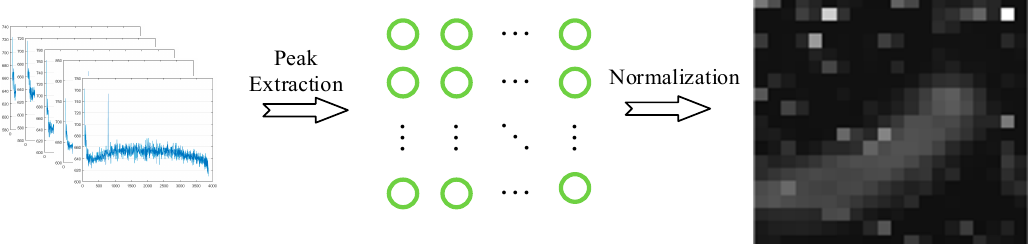
Figure 12. Flow chart of the conversion from Raman spectral data to image.